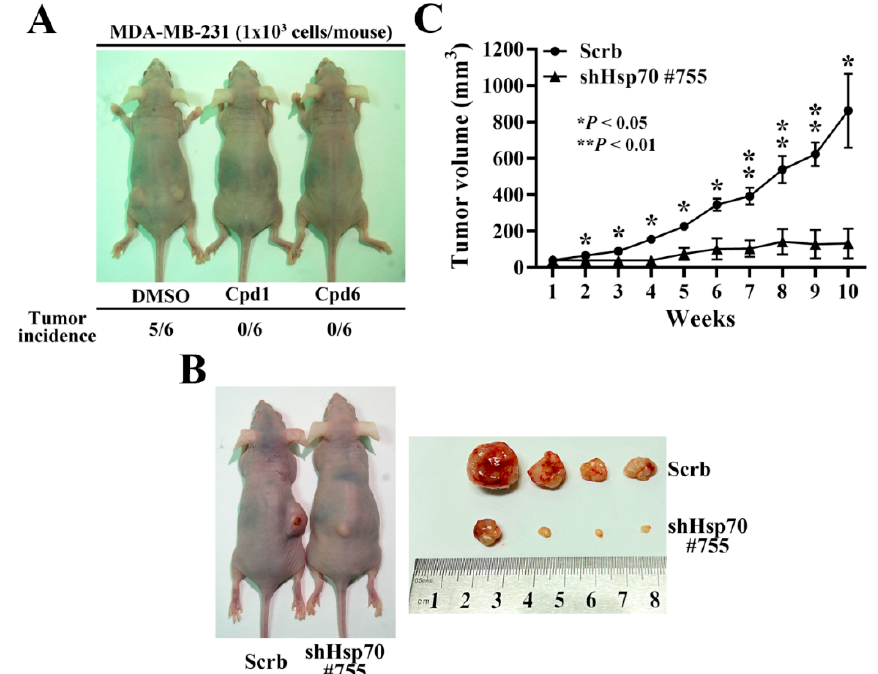
Figure 7. In vivo efficacy of Hsp70 inhibitors and stable Hsp70 knockdown in suppressing MDA-MB-231 tumorigenicity and xenograft tumor growth in nude mice. ( A ) Comparison of the tumor incidence between Hsp70 inhibitors treated and control DMSO treated MDA-MB-231 cells. 1 × 10 3 DMSO, compound 1, or compound 6 treated MDA-MB-231 cells were subcutaneously injected into both flanks of the mice. ( B ) Representative images of stable control knockdown (Scrb) and Hsp70 knockdown clone (shHsp70 #755) on subcutaneous MDA-MB-231 xenograft tumor-bearing mice (left) and dissected tumor samples (right). ( C ) Suppressive effect of Hsp70 knockdown (shHsp70 #755) on subcutaneous MDA-MB-231 xenograft tumor volumes (means ± S.E.M., n = 4). * p < 0.05, ** p < 0.01.